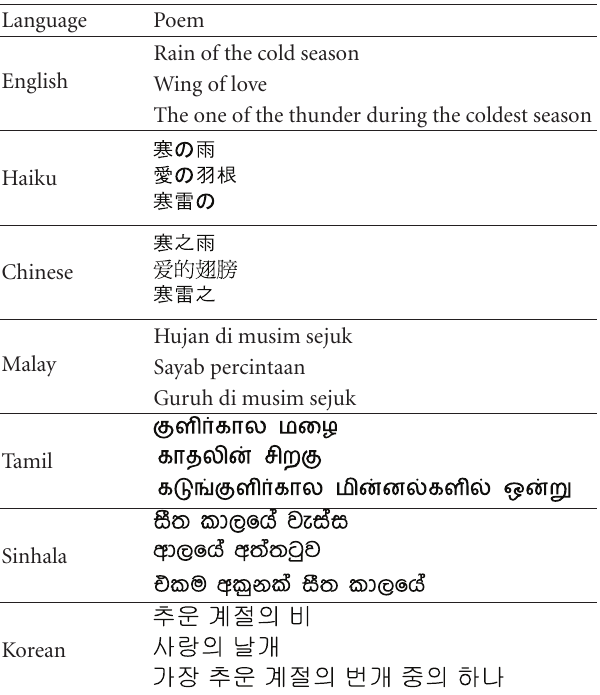
Table 1: Poetry in